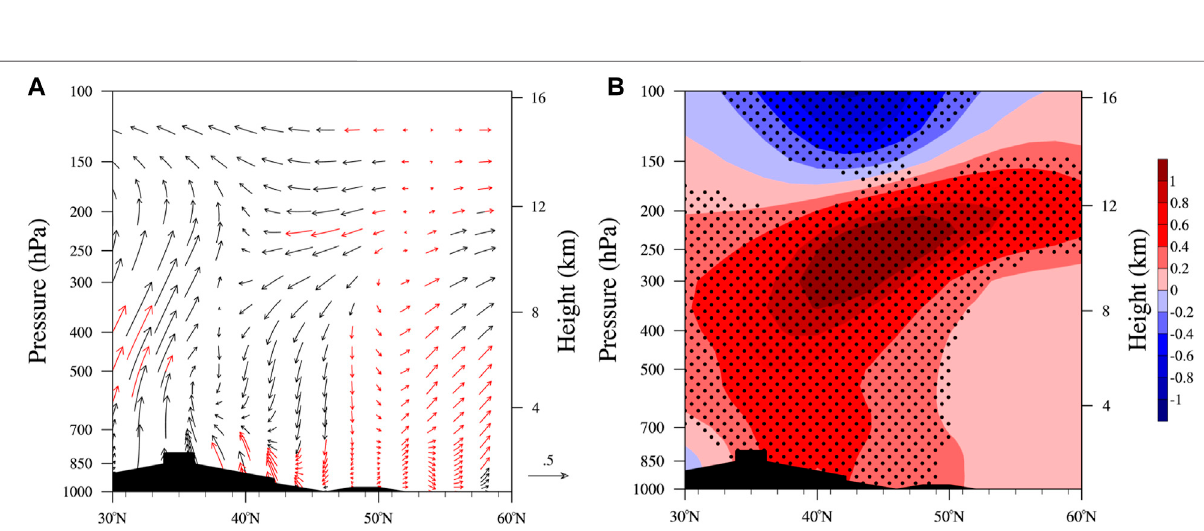
Frontiers in Earth Science |